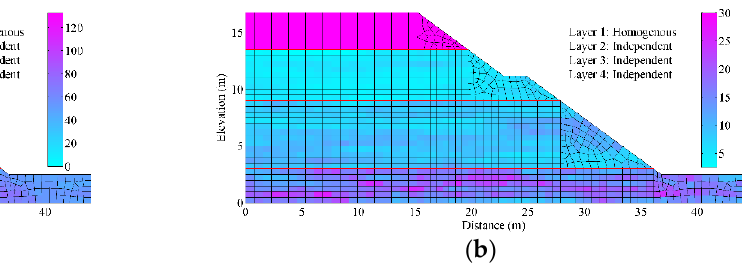
Figure 21. A typical realization of transversely anisotropic CCRF yielded by strategy 5. ( a ) Random field of c. ( b ) Random field of ϕ.